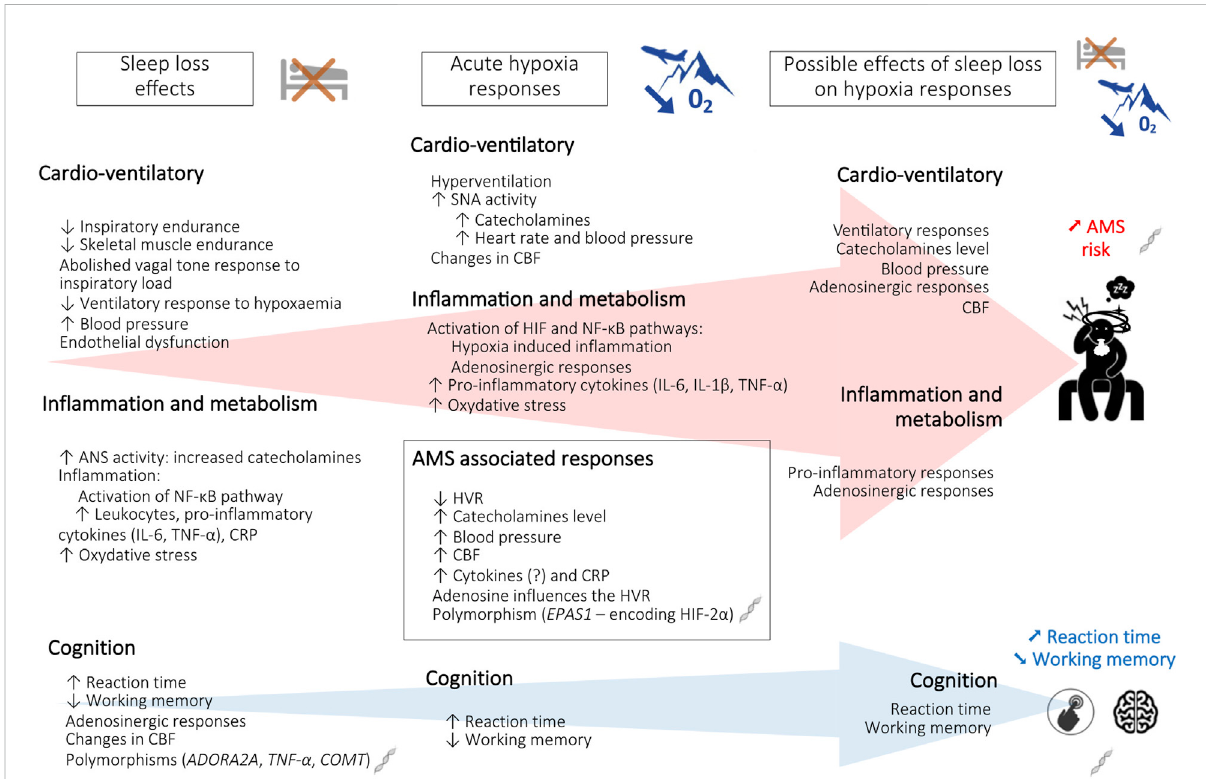
FIGURE 1 Schematic representation of the effects of sleep loss and hypoxia on altitude tolerance [acute mountain sickness (AMS) and cognition]. fl ow; COMT , Catechol-O-methyltransferase gene; ADORA2A , Adenosine A 2A receptor gene; ANS, autonomic nervous system; CBF, cerebral blood CRP, C-reactive protein; EPAS1 , Endothelial PAS domain-containing protein 1 gene; HIF-2 α , hypoxia-inducible factor-2 α ; HVR, hypoxic ventilatory response; IL-6, interleukin-6; IL-1 β , interleukin-1 β ; NF- κ B, Nuclear factor-kappa B; O 2 , oxygen; TNF- α , tumor necrosis factor alpha; TNF- α , Tumor necrosis factor alpha